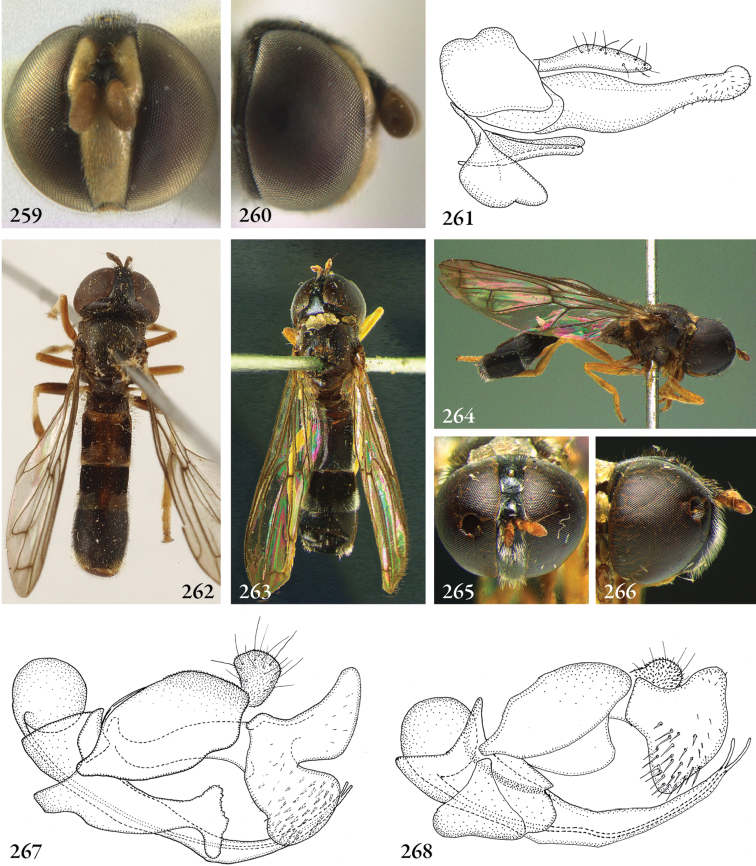
259–260
Paragodon paragoides female (Costa Rica, coll. RMNH) 259 head frontal 260 head lateral 261
Paragodon paragoides male (Panama, coll. SEMC), genitalia lateral. 262
Paramicrodon flukei male (holotype), habitus dorsal. Photo: American Museum of Natural History 263–266
Paramicrodon toxopei male (holotype): 263 habitus dorsal 264 habitus lateral 265 head frontal 266 head lateral 267–268
Paramicrodon, male genitalia: 267
Paramicrodon cf. flukei (Peru, coll. RMNH) 268
Microdon toxopei (holotype).